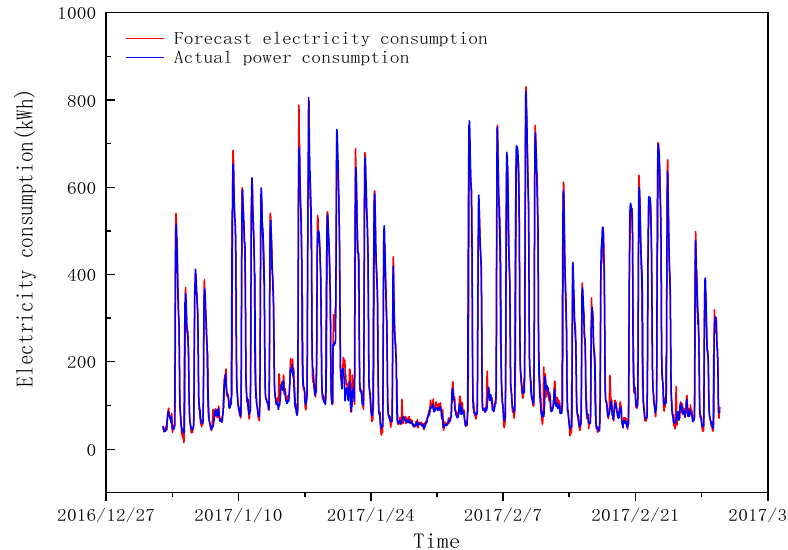
Figure 8. Air-conditioning electricity forecast in 2017.